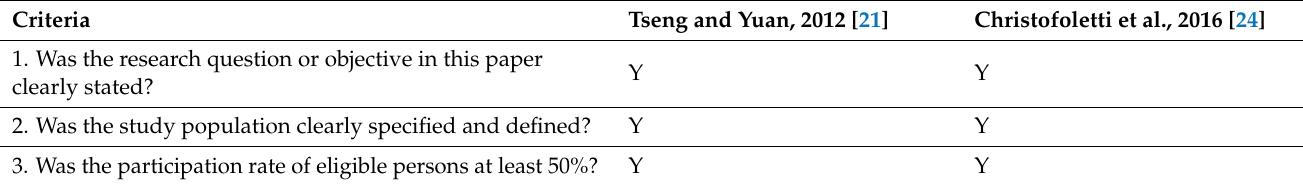
Table A1. Summary of walking conditions used in the included